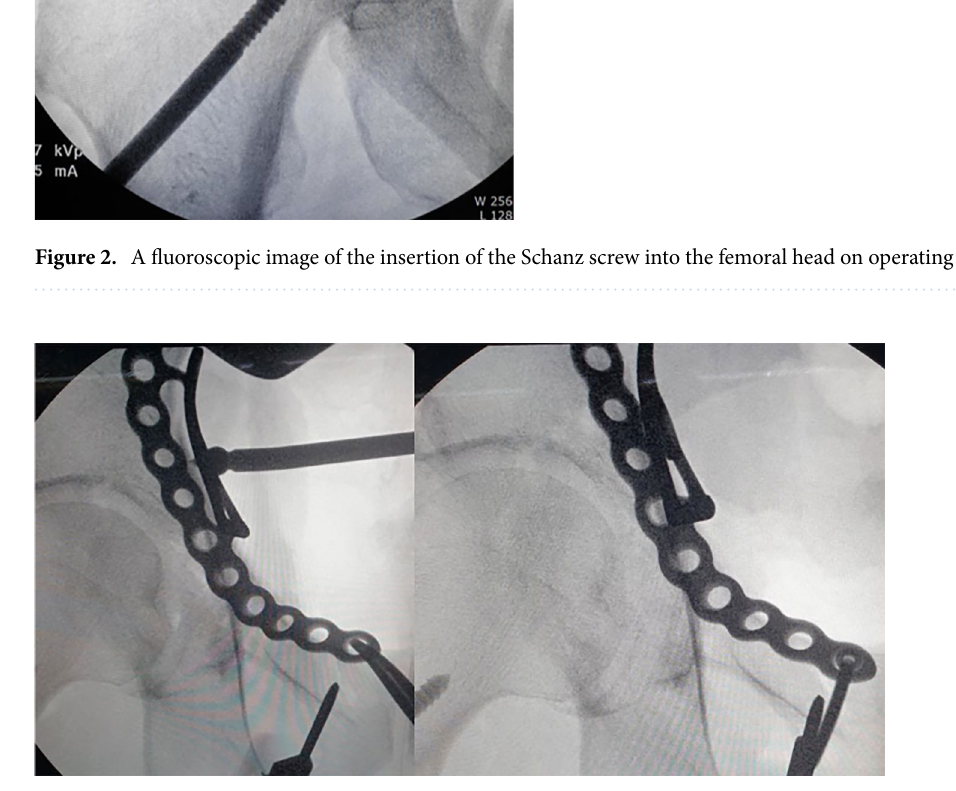
Figure 3. Fluoroscopic images of attaching the quadrilateral surface plate to quadrilateral surface using a ball spike